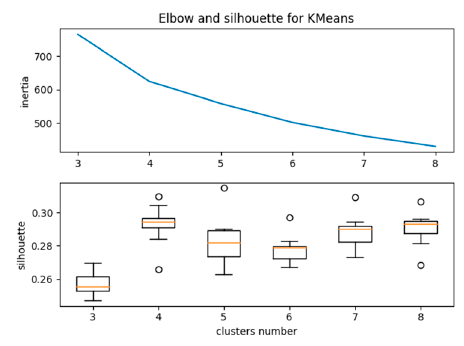
Figure 6. Elbow and silhouette plots for choosing the number of clusters for K-means.